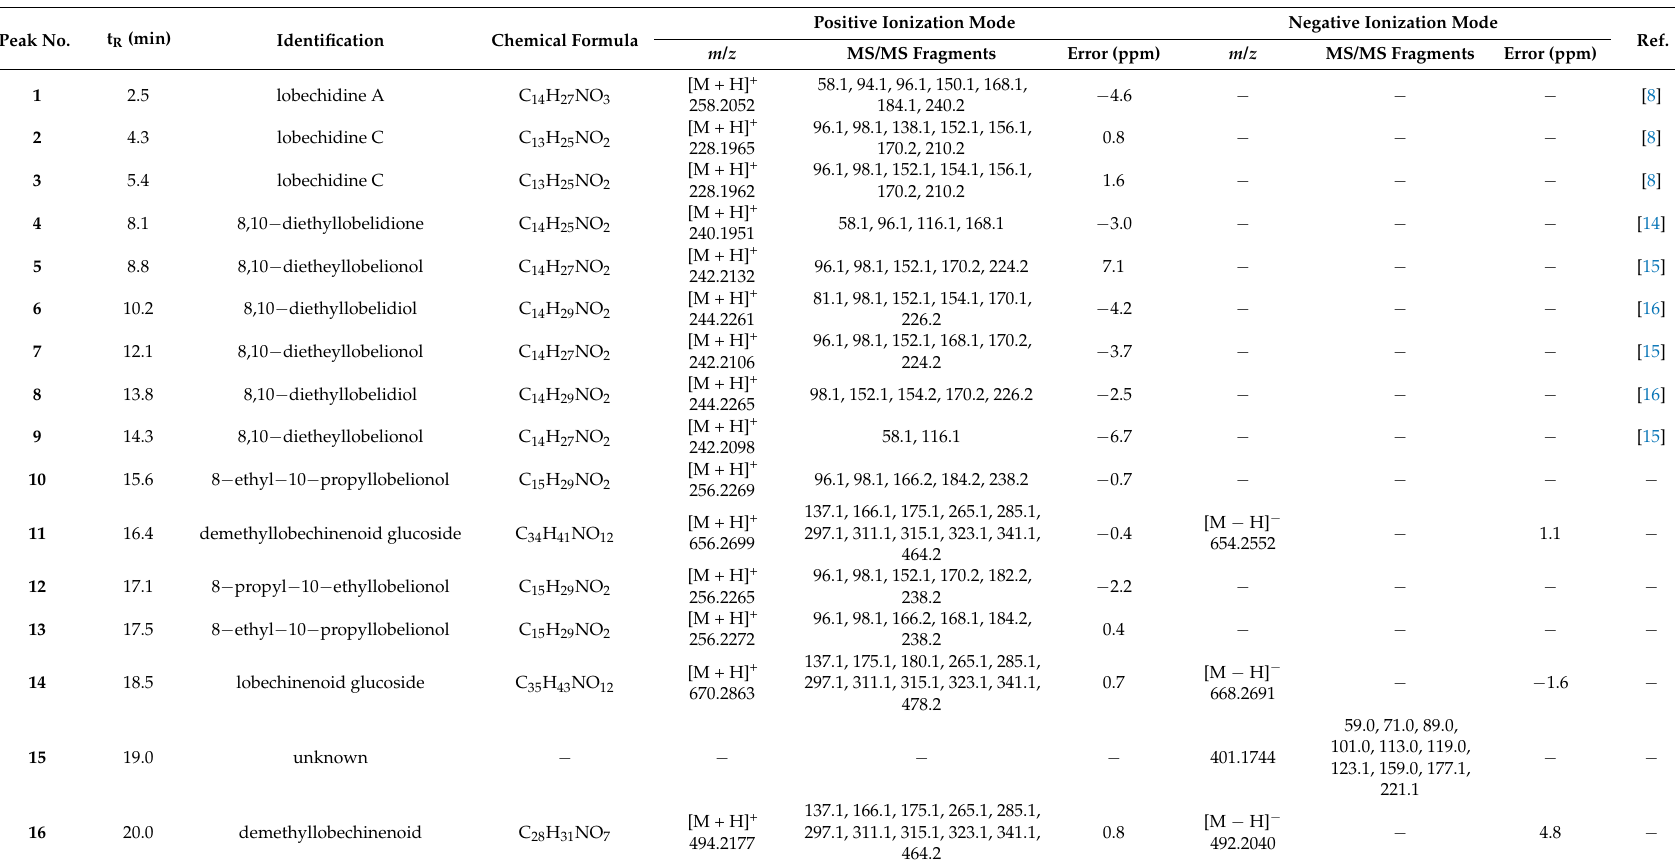
Table 2. Chemical constituents identified from L. chinensis with the high-performance liquid chromatography coupled with quadrupole time-of-flight mass spectrometry (HPLC/Q-ToF MS) method in both positive and negative ionization modes. Peak